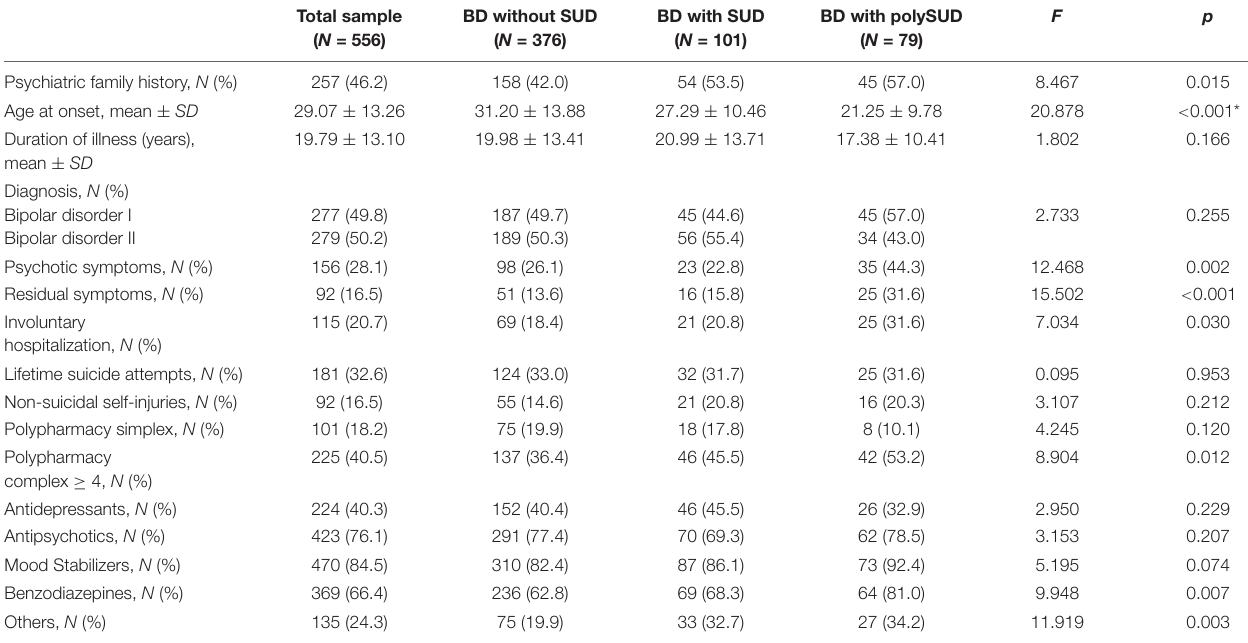
TABLE 2 | Clinical characteristics of the total sample and comparison between the three